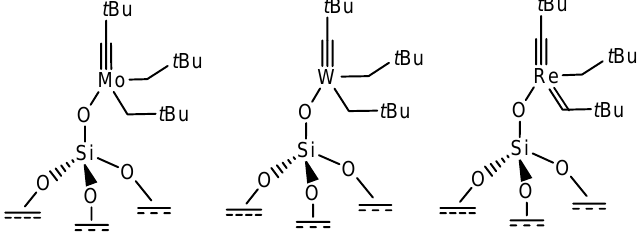
Figure 9 . Single-site active centers designed to catalyse metathesis reactions and deposited onto a silica